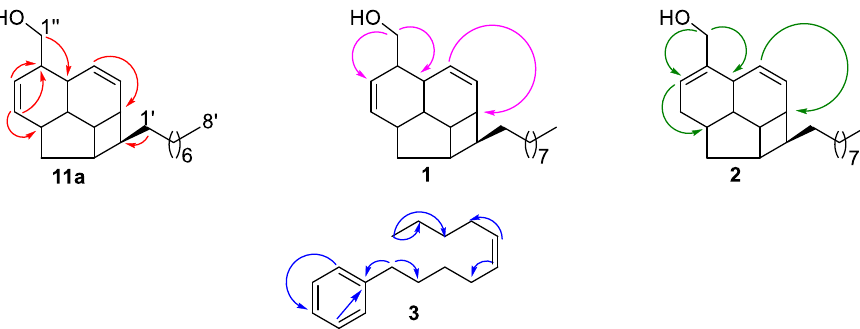
Figure 2. Key HMBC ( → ) correlations for compounds 11a, 1 , 2, and 3 .